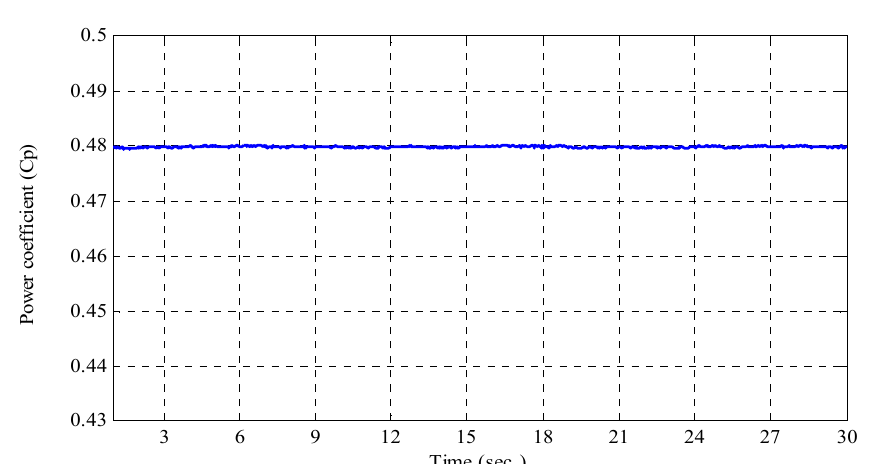
Figure 14. Power coefficient ( C